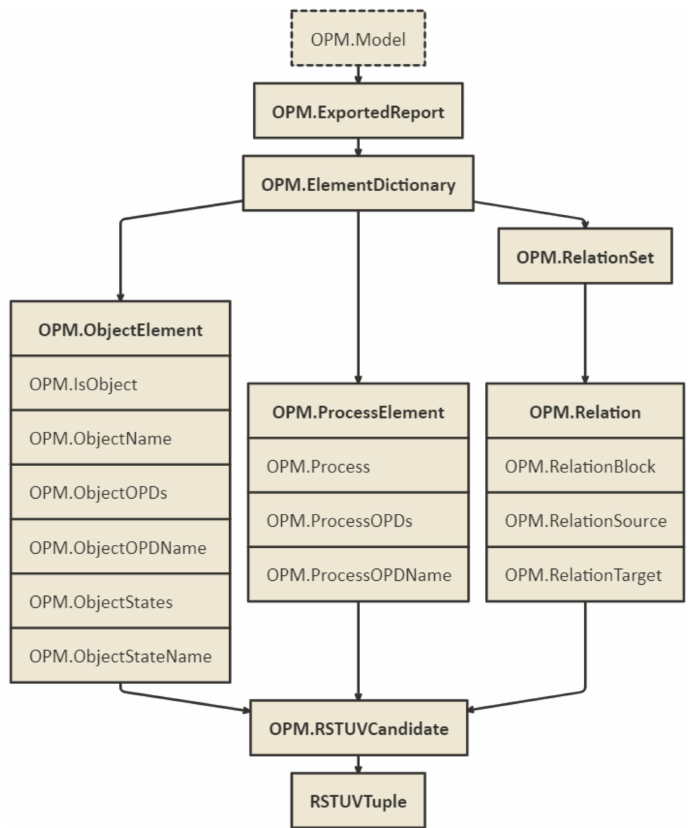
Figure 8. A C-Set mapping functor schema from OPML to GDS (RSTUV tuple set) extracts ElementDictionary from the model’s ExportedReport and transforms ElementDictionary into three sets: ObjectElement , ProcessElement , and RelationSet . RelationSet is decomposed into a set of Relations . The functor computes attributes for each entity type from the report. For example, it lists the ObjectOPDs in which each Object is defined, and extracts the Source object/process and the Target object/process for each Relation . Each entity is then transformed into a set of RSTUVCandidates . Duplicate candidates are removed before the set of RSTUVTuple is compiled. Illustration created using the